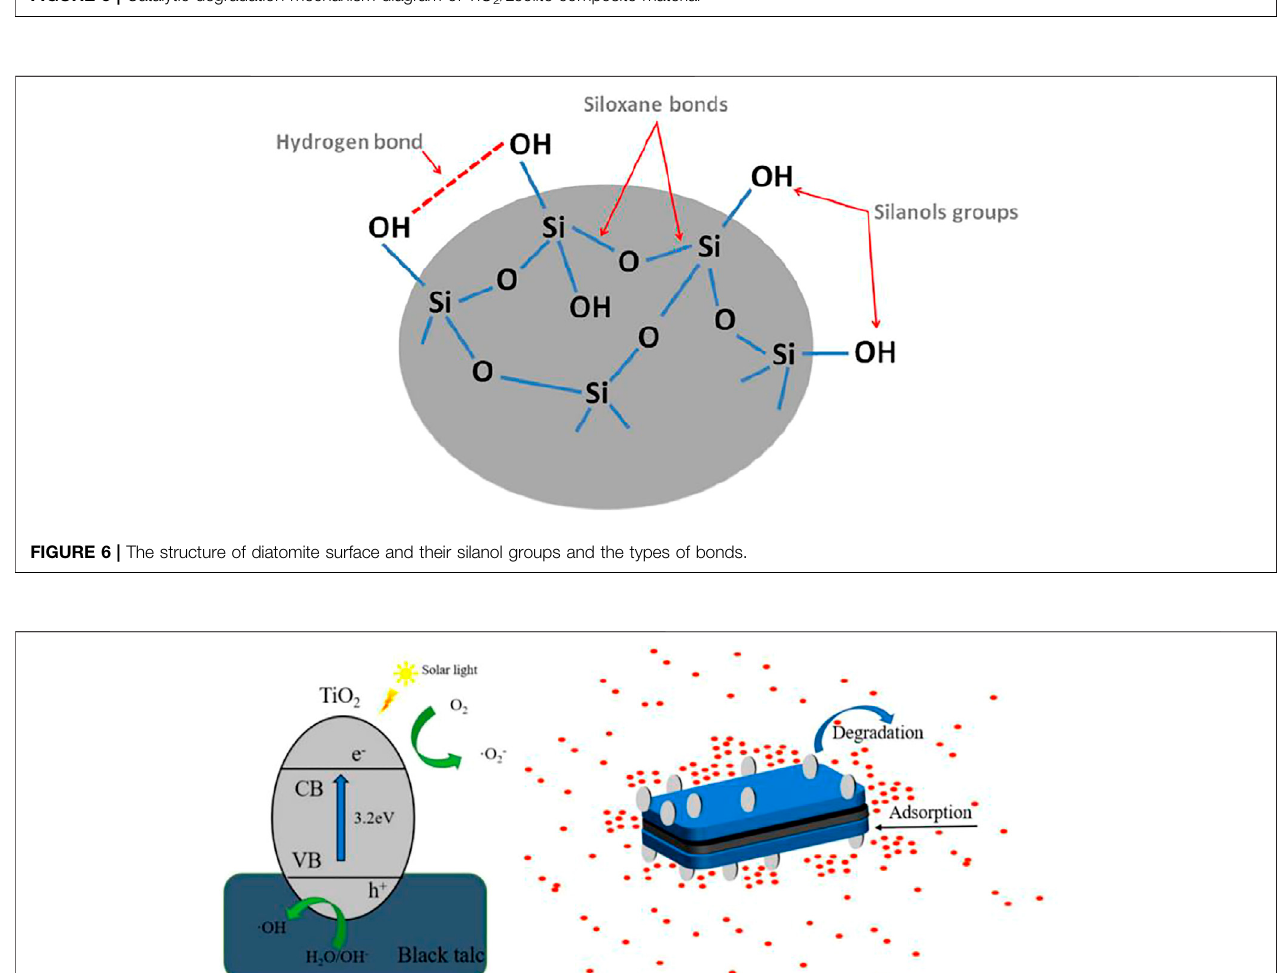
Frontiers in Catalysis |